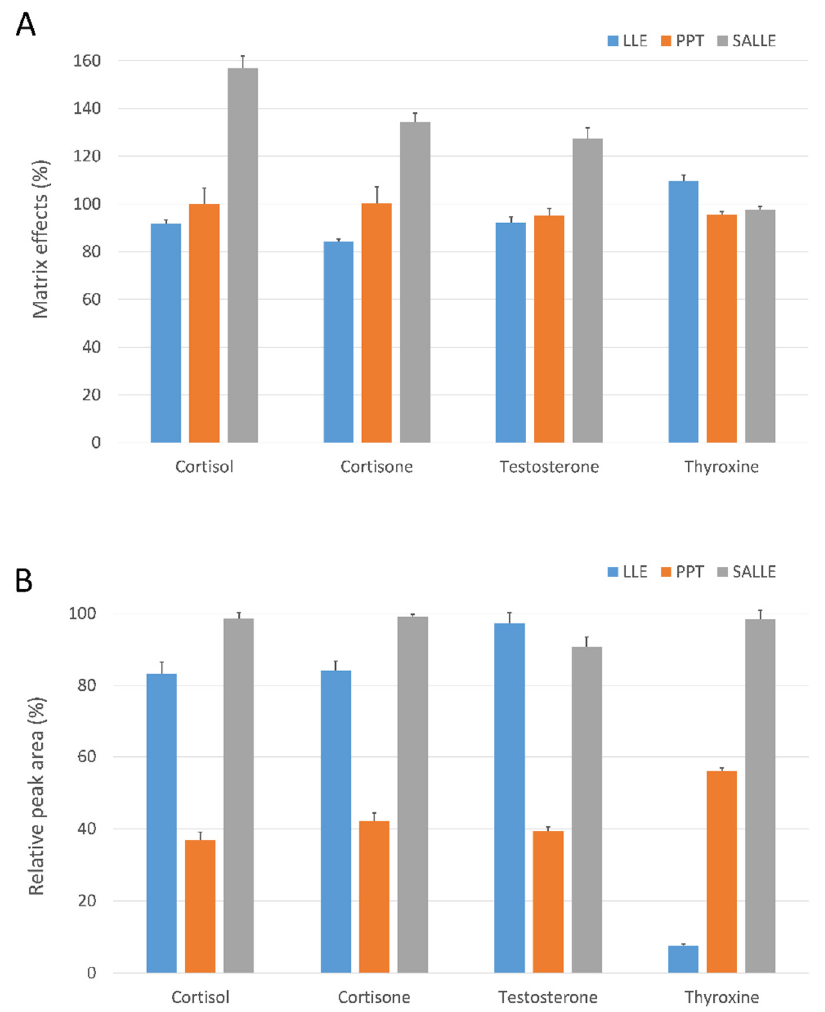
Figure 4. Comparison of the final SALLE protocol with both LLE using MTBE and PPT using ACN, for the extraction of thyroxine and steroid hormones from a human serum control sample. ( A ) shows matrix effects (%) relative to measurement in pure acetonitrile and ( B ) shows average peak area (%) relative to the highest peak area among all the extraction methods. Data are reported as mean + standard deviation, n = 4.